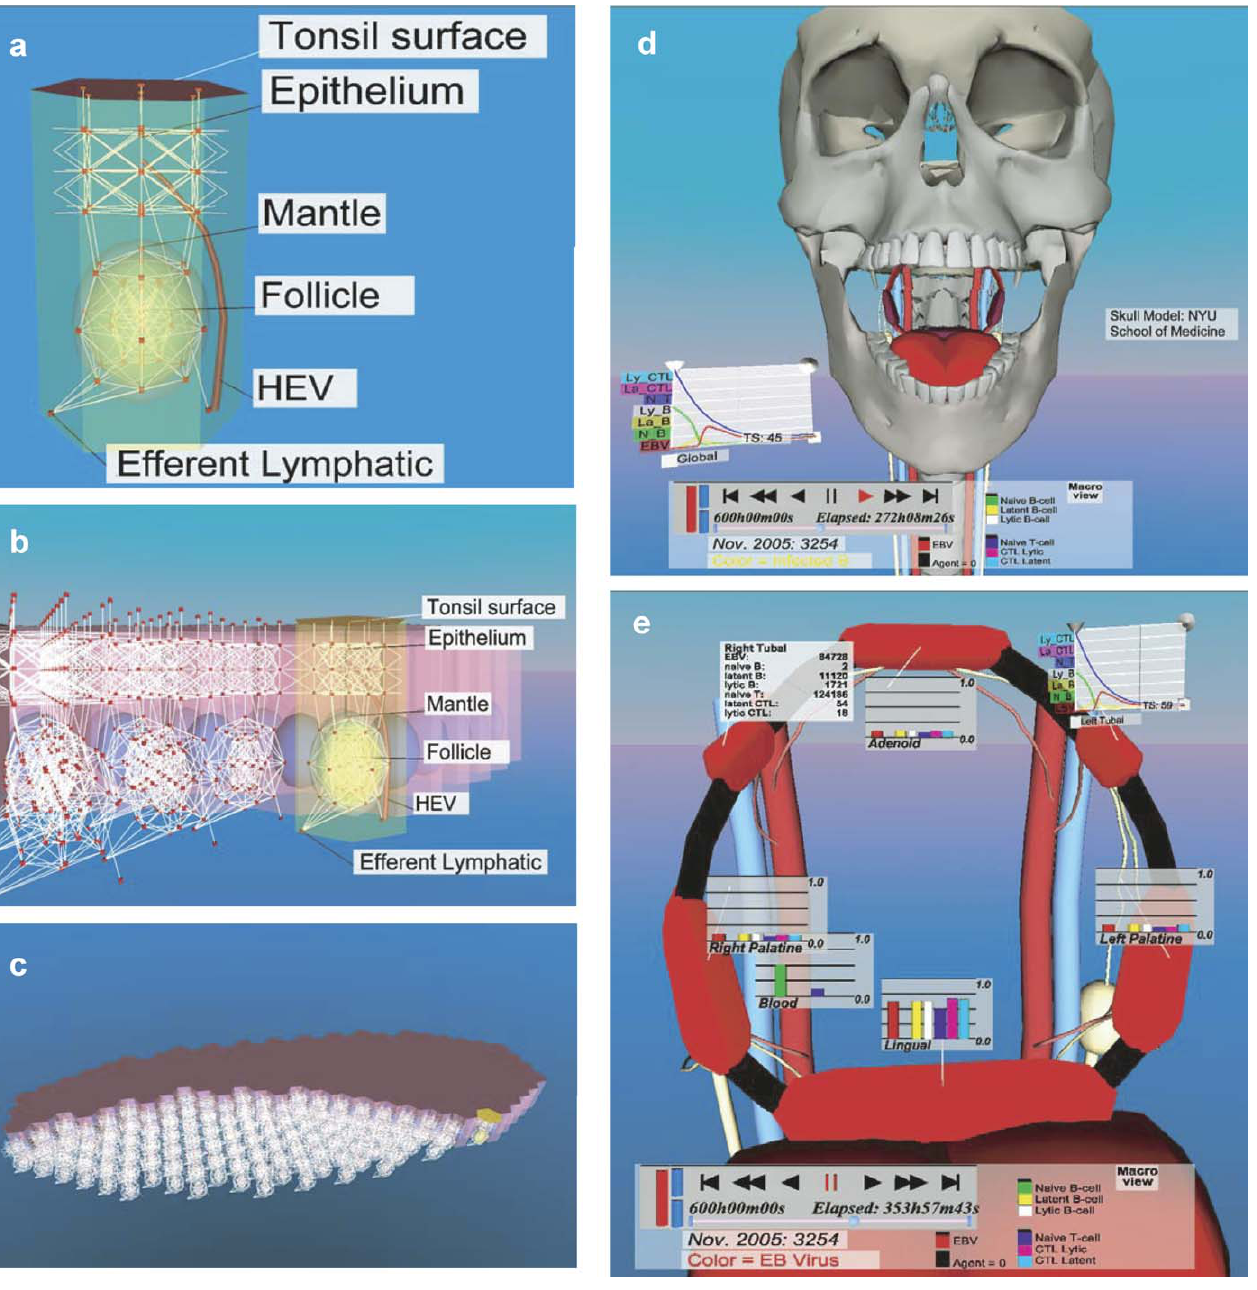
Figure 2. Representative Fields from the Simulation’s Virtual Environment (IRVE) For more details on (A–C), see Video S1, and for more on (D and E) see Video S2. (A) The basic unit, used to construct the tonsil grid, consists of a solid hexagonal structure representing surface epithelium, lymphoid tissue, and a single germinal center/follicle. The virtual grid along which the agents move is shown as white lines, and the nodes where agents reside and interact are depicted as red boxes. Each hexagonal unit has one HEV entry point from the peripheral blood and one exit point into the lymphatic system. (B) A view from the side of a single tonsil showing how the hexagonal base units are packed to create the entire grid of the tonsil lymphoepithelium. (C) An overview of a single complete tubal tonsil showing part of its surface and part of its internal structure. (D) Skull level view of the simulation showing the on screen control panel (bottom of figure) and an example of one form of graphic representation of the global status of the infection (line graphs, left). (E) A view at the level of the entire Waldeyer ring demonstrating different methods of quantitation. Graphics in the form of numbers (top left) or bar graphs for a given time step and time line graphs (top right) are shown for various compartments of the simulation. The color signature for the ring is red, which denotes free Vir. The color of the ring denotes the type and level of agent being shown. In this case, the intense red color indicates a high level of free Vir throughout the ring (for an example of infection spreading throughout a single lymph node or the entire ring visualized by changing color intensity, see Figure 3 and Video S2). Note also the draining lymphatics (white vessels) and peripheral circulation (red and blue vessels). These images are screen shots taken on 7/30/2006.